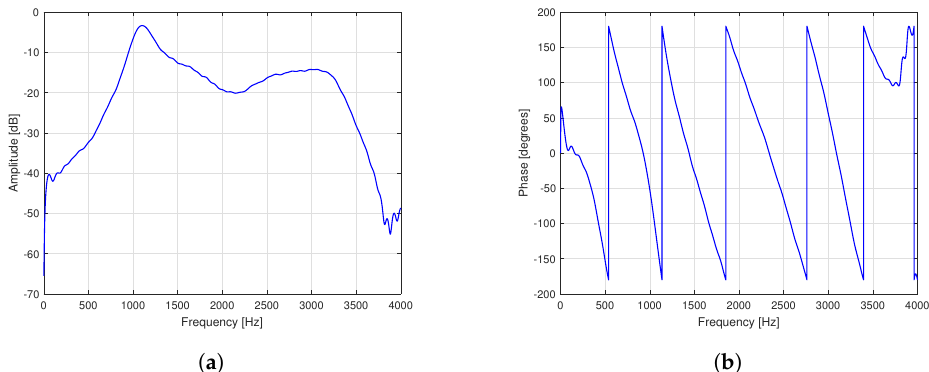
Figure 15. The measured feedback path for Experiment 4: ( a ) Amplitude response and ( b ) phase.